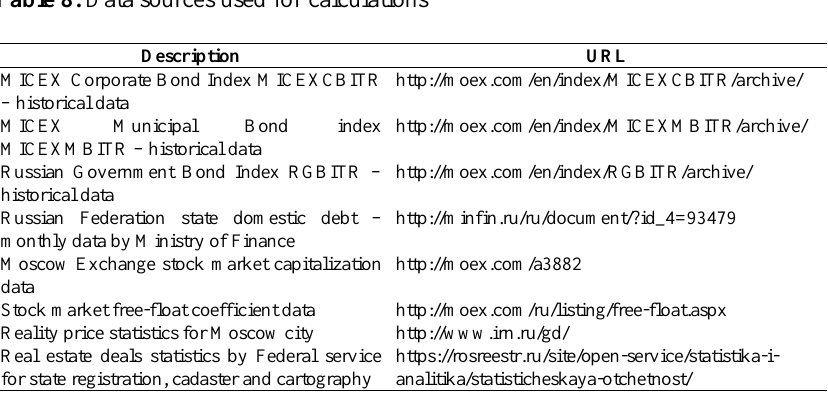
Table 8. Data sources used for calculations